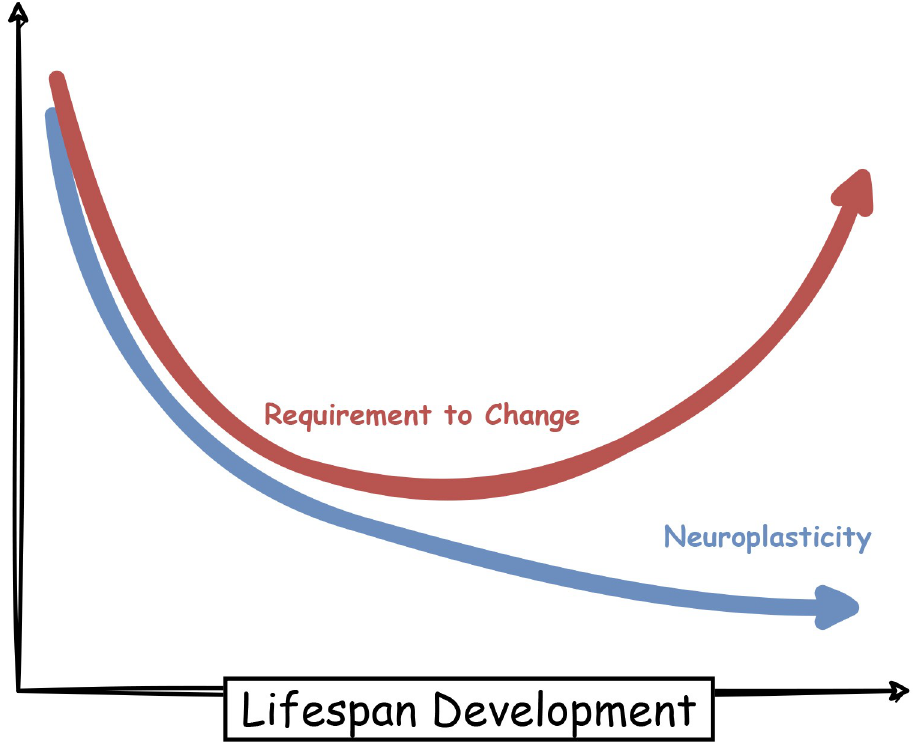
Fig 6. Schematic describing the alteration of neuroplasticity and requirement to change over the